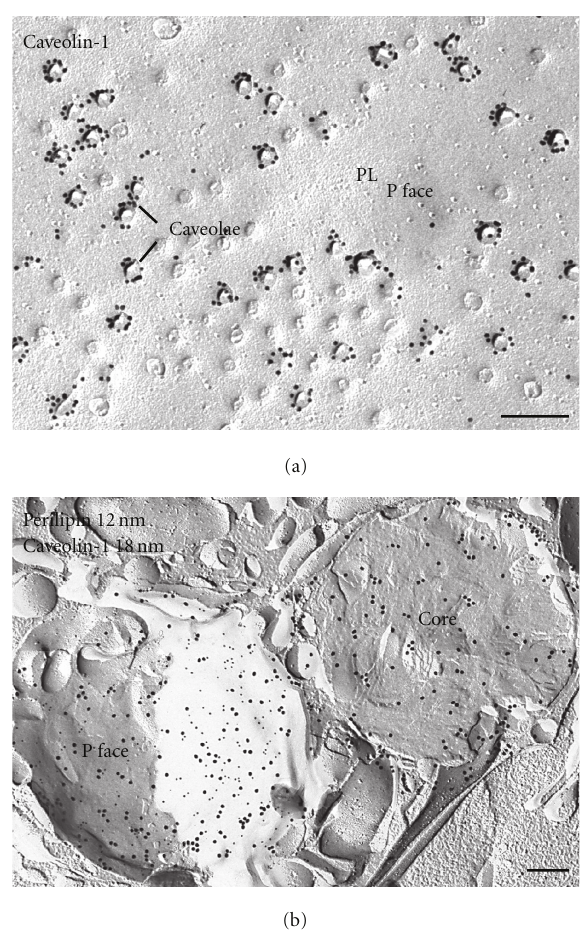
Figure 9: Distribution of caveolin-1 and perilipin in adipocytes. (a) Caveolae appear as dimples in the P face of the plasmamembrane of adipocytes. Gold particles label cavolin-1 in the P face at caveolae. Caveolin-1 labeling is found mainly at the rims of deep caveolae. Apart from positive labeling of caveolae in the plasma membrane, abundant label of caveolin-1 is found in the lipid droplet. (b) Example of immunogold labeling of perilipin (12nm gold) and caveolin-1 (18nm gold) in two lipid droplets of the same cell. One droplet shows colocalization of both proteins in the outer monolayer (P face) in almost equal amounts, whereas the other is cross-fractured and the core contains almost exclusively caveolin-1 label. Bars: 0.2 μ